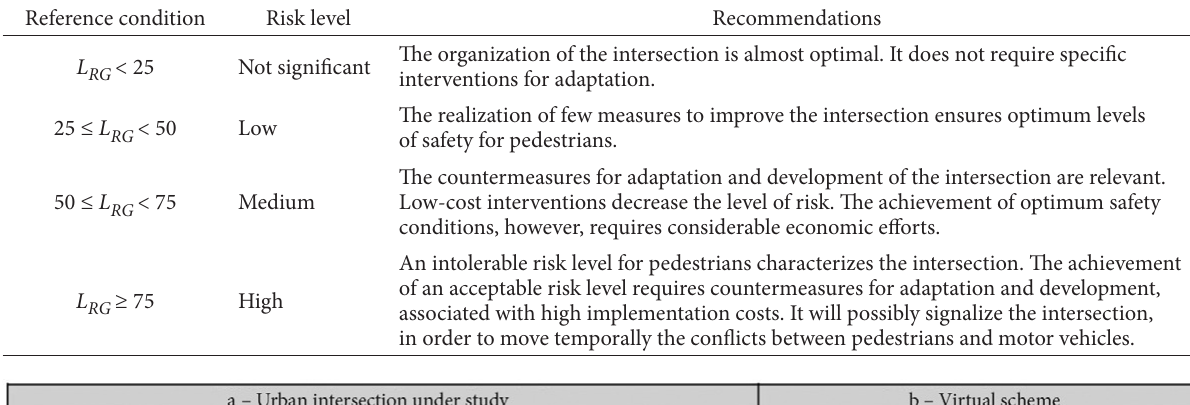
Table 7. Risk levels of pedestrian accidents for road